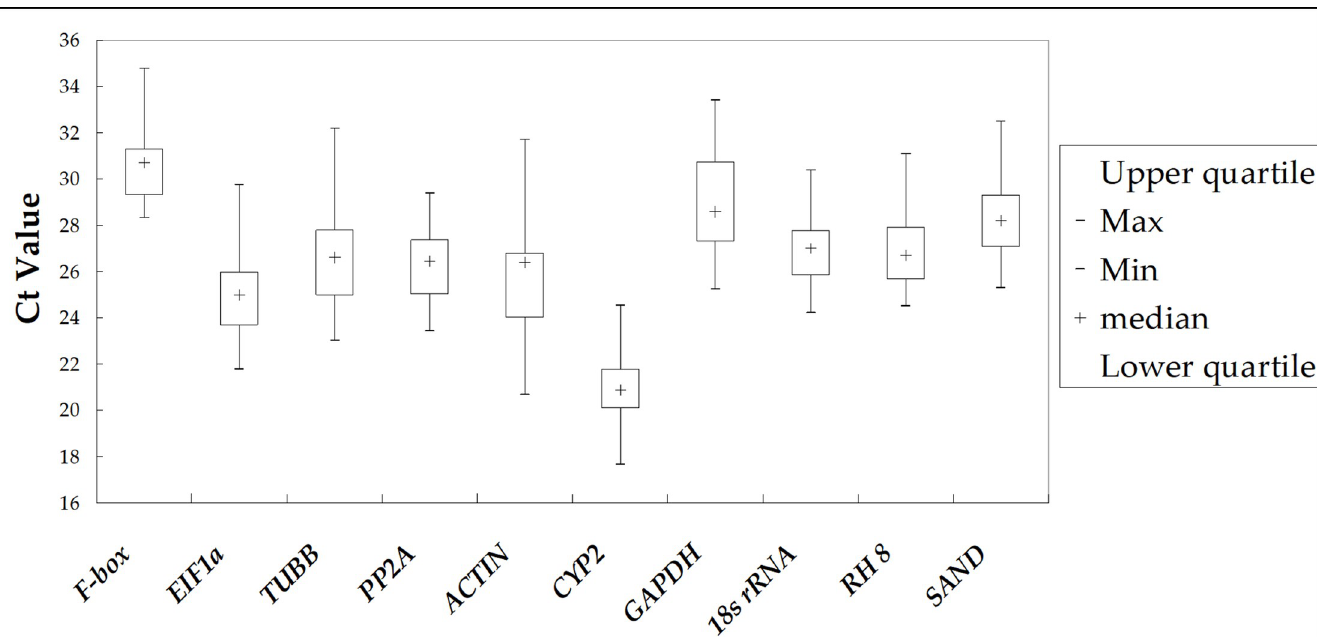
Fig 1. Box-plot based on cycle threshold (Ct) of 10 candidate reference genes in all experimental samples. The Ct value for each gene is the average of three biological replicates. The block diagram represents the quartile range (25th to 75th percentiles) of Ct values; the ‘+’ in the box depicts the median of the Ct value; underline and overline are determined by the minimum and maximum values of the Ct